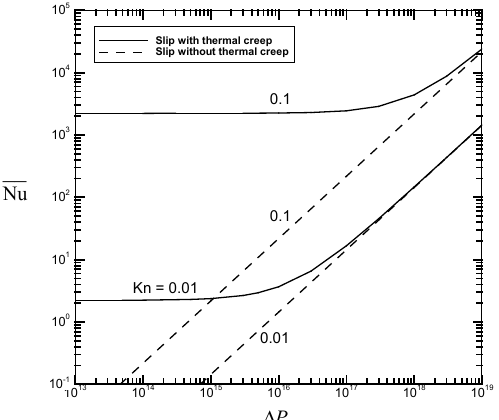
Figure 4. Average flow drag Γ versus the dimensionless pressure drop ∆ P for different values of Kn with GrL = 10 2 and Ec = 10 −20 .